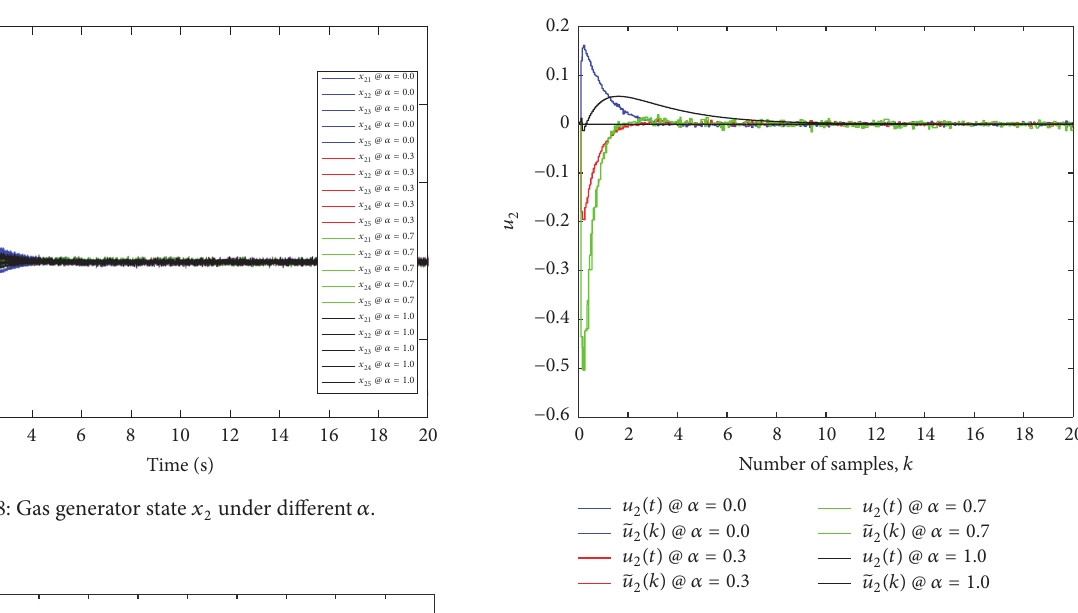
Figure 10: Gas generator controller output 𝑢 2 under different 𝛼 .